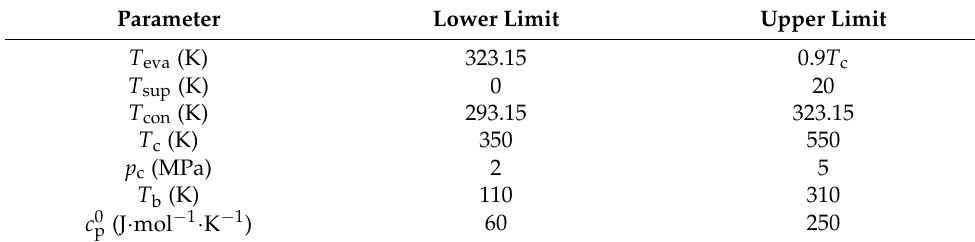
Figure 11. Flow chart of the optimization problem. Table 7. Variation range of characteristic parameters.